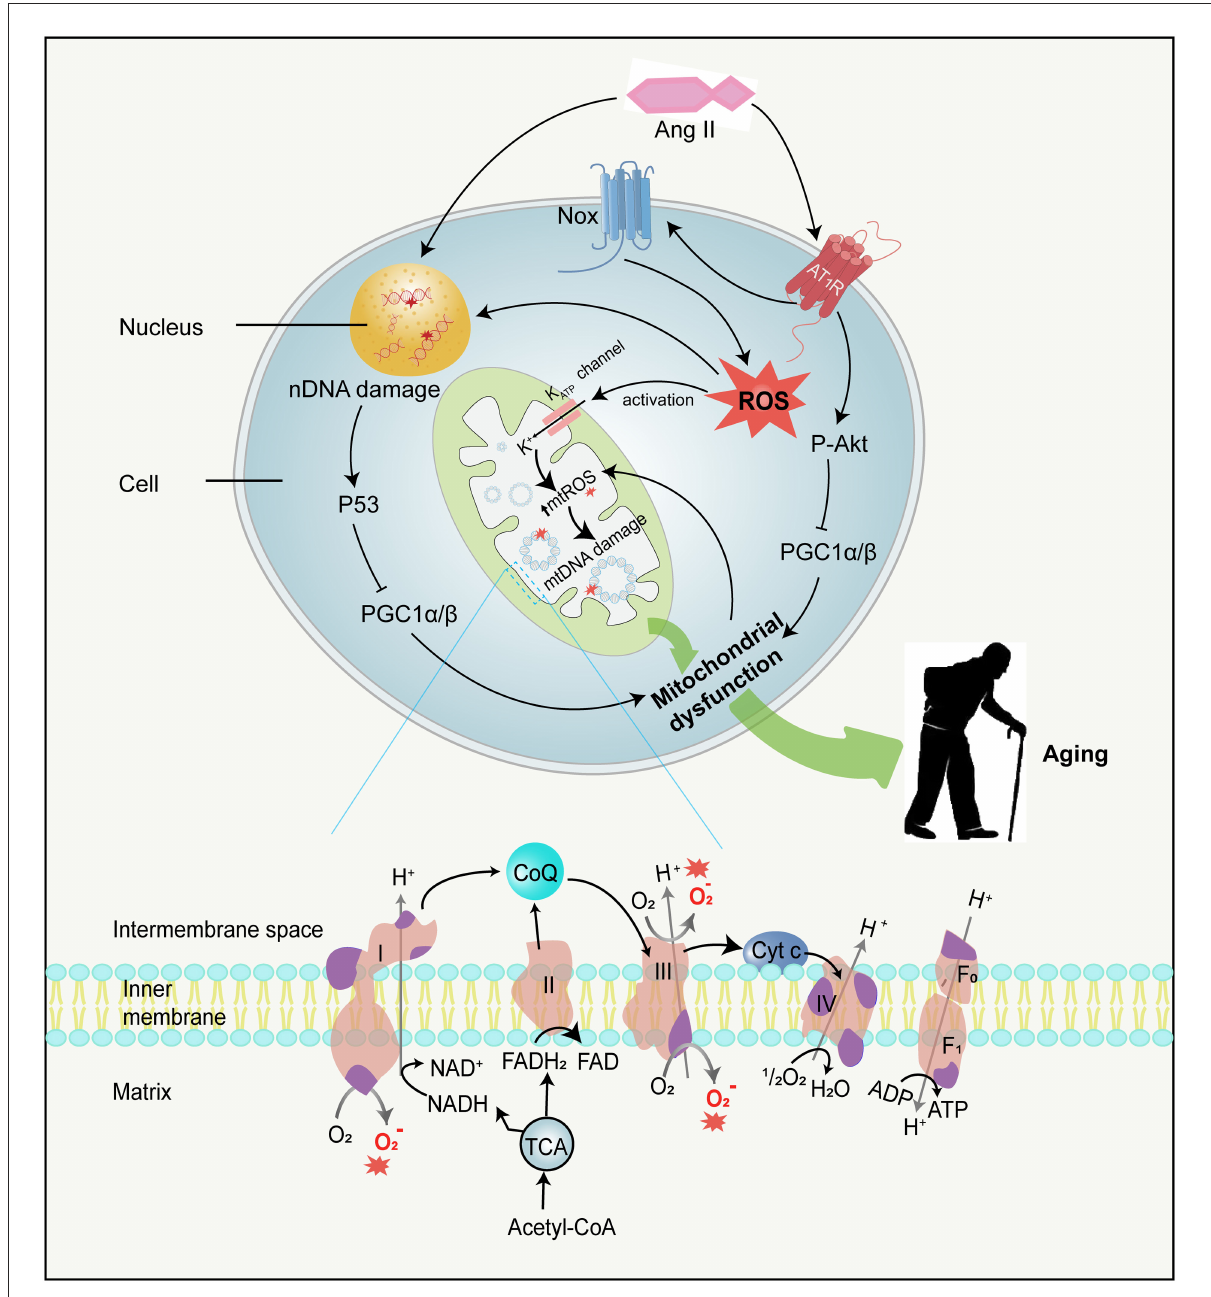
FIGURE3 Ang II and mitochondrial dysfunction. Ang II can not only damage mtDNA by stimulating mtROS production in several ways but also damage nDNA directly. MtDNA mutations directly accelerate mitochondrial dysfunction, while nDNA damages result in mitochondrial dysfunction by activating P53 and subsequently inhibiting PGC-1 α andPGC − 1 β , therefore contributing to aging. Besides, Ang II binding to AT 1 R activates Akt and in turn phosphorylates PGC-1 α / β , leading to mitochondrial dysfunction. The mitochondrial ETC is composed of four respiratory complexes (1-IV) and ATP synthase(F 0 − 1 ), which are all made up of proteins encoded by both mitochondrial (purple) and nuclear (pink) genes. MtROS (red asterisk) are primarily generated from complexes I and III in the ETC. mtDNA, mitochondrial DNA; nDNA, nuclear DNA; PGC-1 α and PGC-1 β , peroxisome proliferator-activated receptor gamma coactivator 1-alpha and -beta; ETC, electron transfer chain; ATP, adenosine triphosphate; Cyt c, cytochrome c; ADP, adenosine diphosphate; NADH, nicotinamide adenine dinucleotide; FAD, flavin adenine dinucleotide; FADH 2 , flavine adenine dinucleotide reduced; CoQ, Coenzyme Q; TCA, tricarboxylic acid